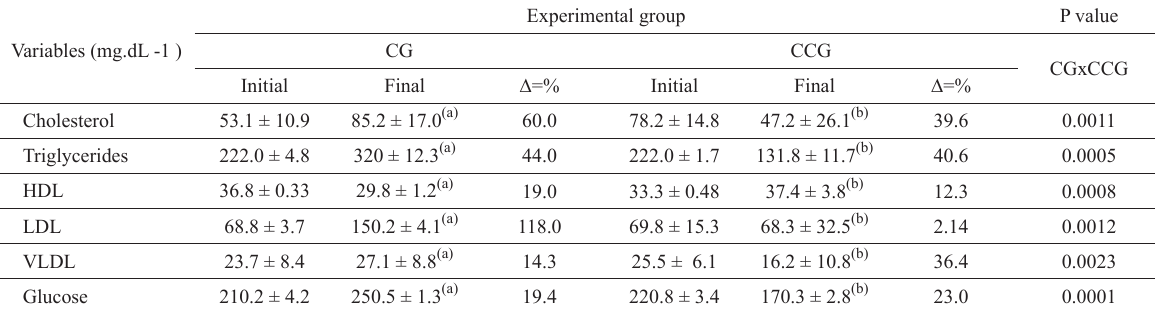
Lipid and glucose profiles in obese rats treated with Camu-camu